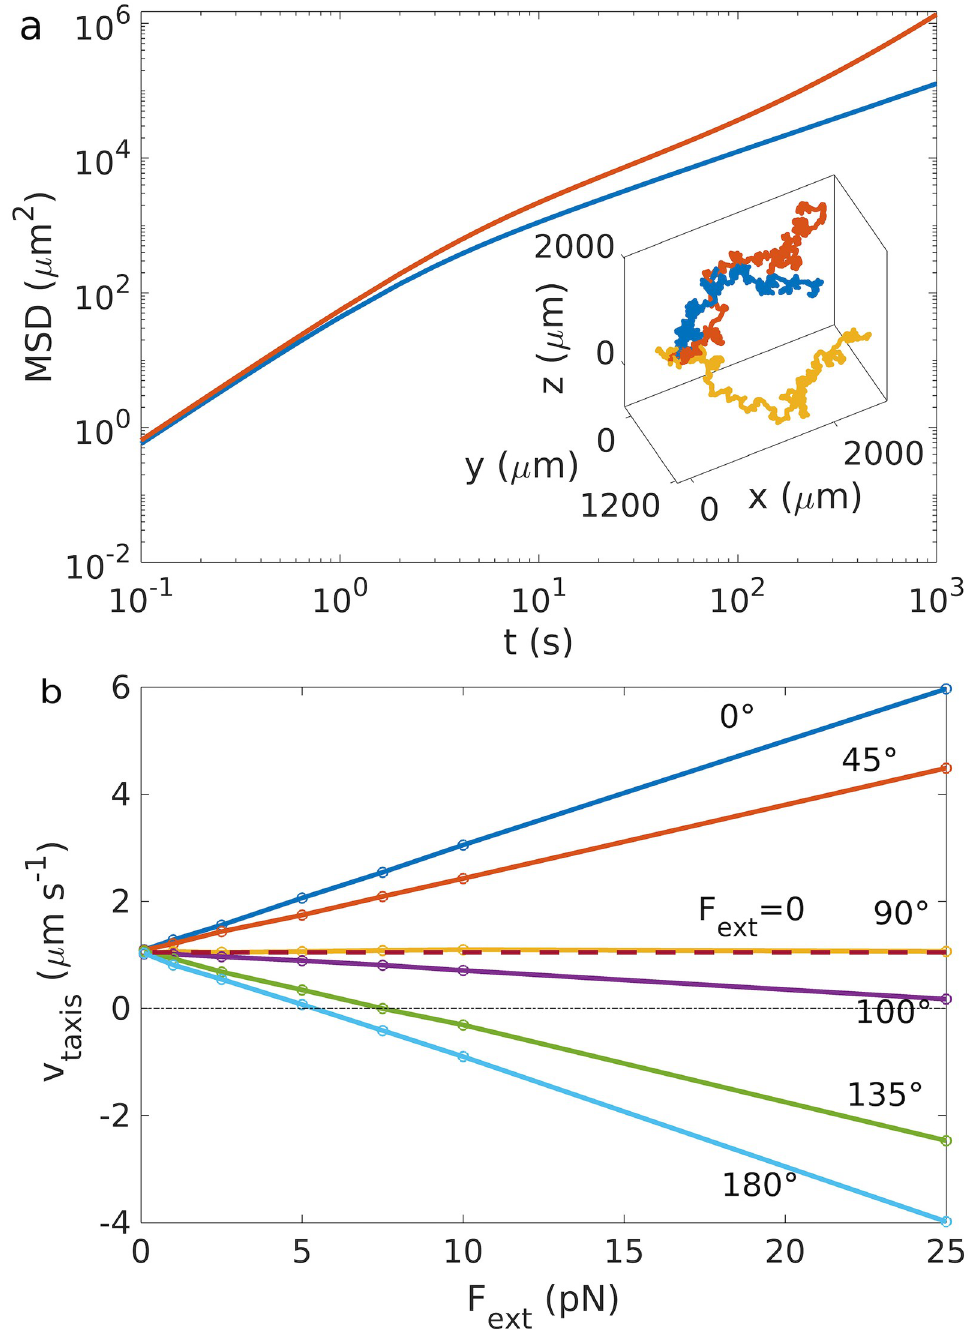
Fig 2. Chemotaxis without/with forces. a) Comparison between the mean square displacement with (red) and without chemotaxis (blue). Inset: three different realizations of trajectories with chemotaxis towards an attractant with gradient directed along þ ^ x . b) Taxis velocities in the presence of a constant force at different angles θ F, r C relative to the concentration gradient and with different absolute values F ext . The dashed line corresponds to the case without force. For the used parameters, see S1